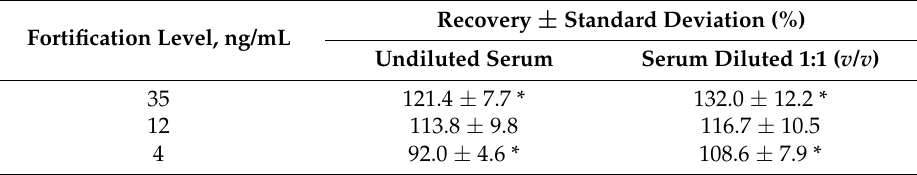
Table 3. Determination of tetracycline in human serum by the developed assay ( n = 3). Fortification Level, ng/mL